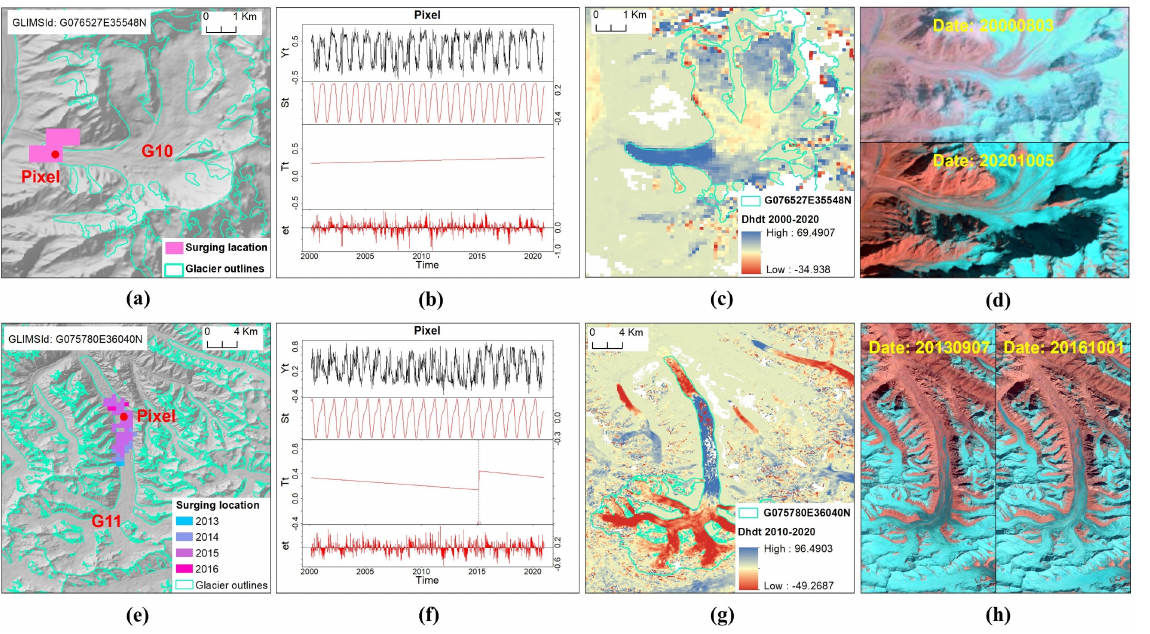
Figure 6. Examples of surging at fully debris ‐ covered glacier tongues. The GLIMS IDs for G10 and G11 are G076527E35548N and G075780E36040N, respectively. See Figure 1 for the locations of the two glaciers. ( a , e ) The surging locations and years of surge initiation; ( b , f ) the decomposed components of the NDSI time series at the surge ‐ affected pixel (red dots in ( a , e )); ( c , g ) the elevation changes of glaciers G10 and G11; ( d , h ) the corresponding false ‐ color composites (band 6 − SWIR1, 5 − NIR, 4 − Red as RGB) of the Landsat imagery before and after surging.